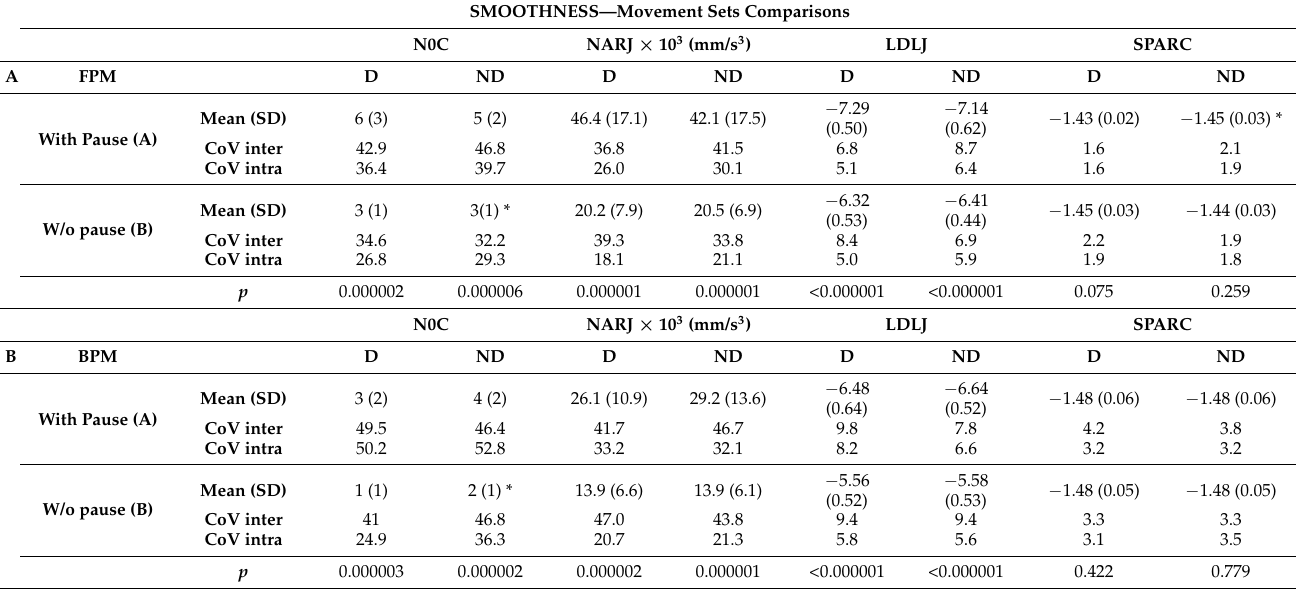
Table 3. Movement set comparisons for a given